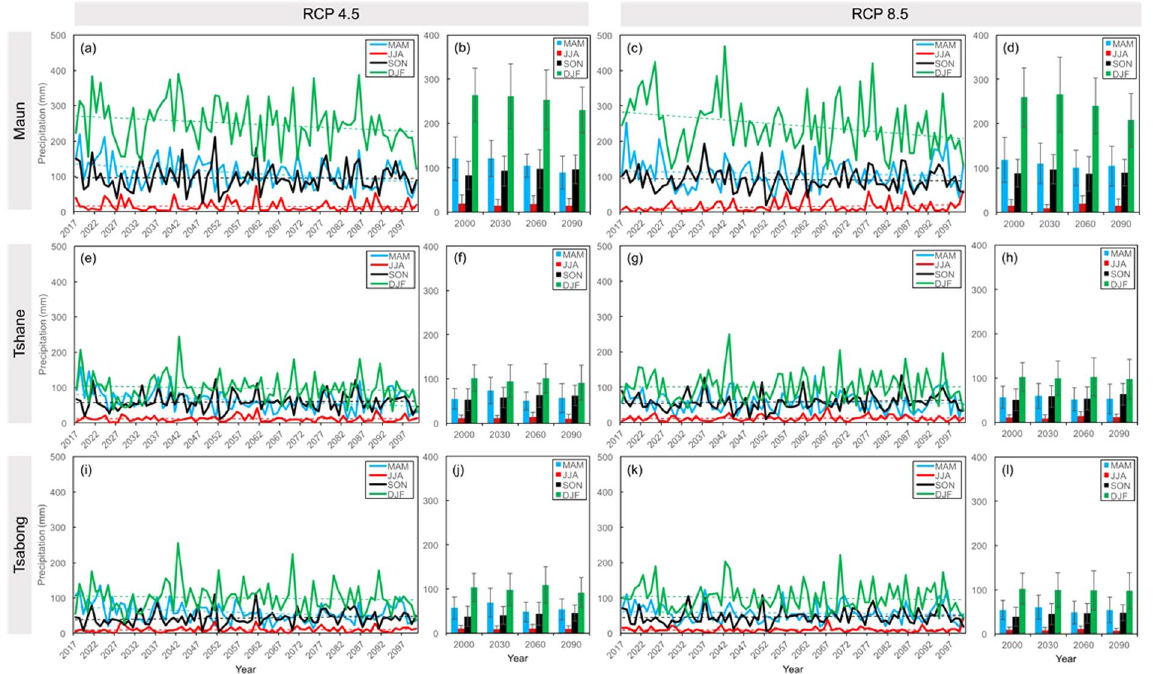
Figure 2. ( a , c , e , g , i , k ) Projected changes in precipitation, separated by season, over the period 2017–2100 at each study site. Dotted lines show linear best fit trends; ( b , d , f , h , j , l ) mean total precipitation in each season, for the chosen years (2030, 2060, 2090) and baseline year (2000). Error bars show standard